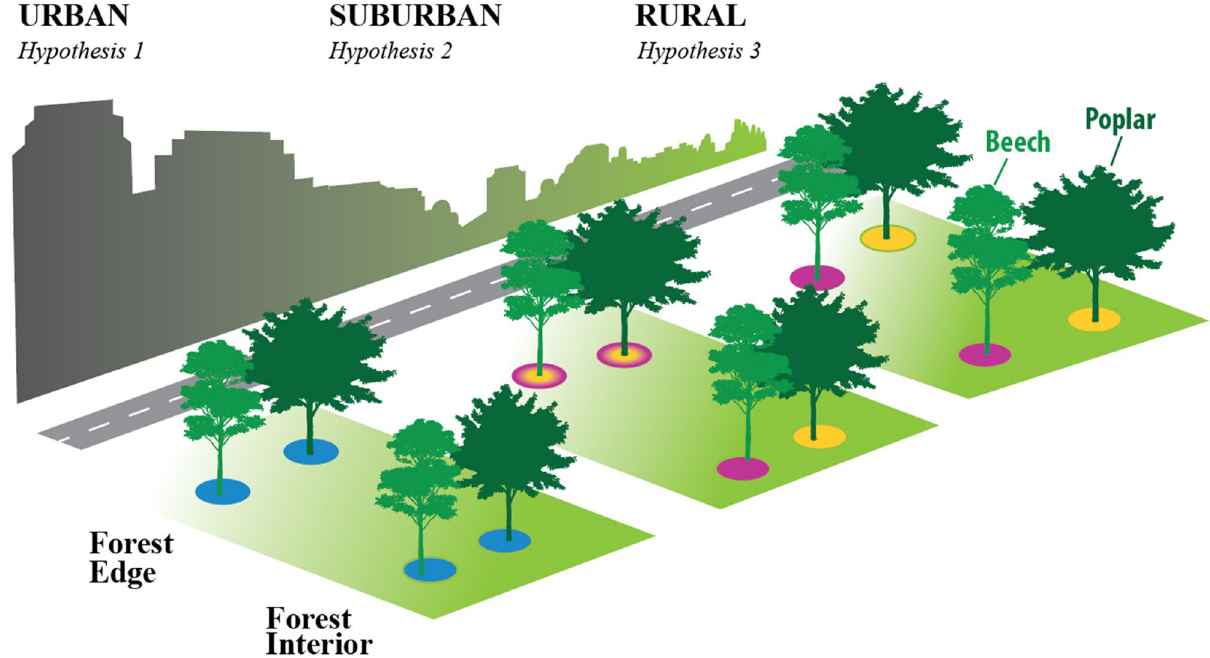
Figure 1. Conceptual diagram of hypothesized soil microbial community (SMC) structural changes [represented at tree bole via colored circles (for example, unique colored circles signify dissimilarity of the SMC)] in response to tree species (beech vs. yellow poplar) forest type (rural, suburban, and urban) and location (interior vs. edge). Additionally, diagram provides on overview of our sampling methods as all forest edge locations were directly adjacent to a roadway and interior locations were ~ 100 m from defined roadway edge. H